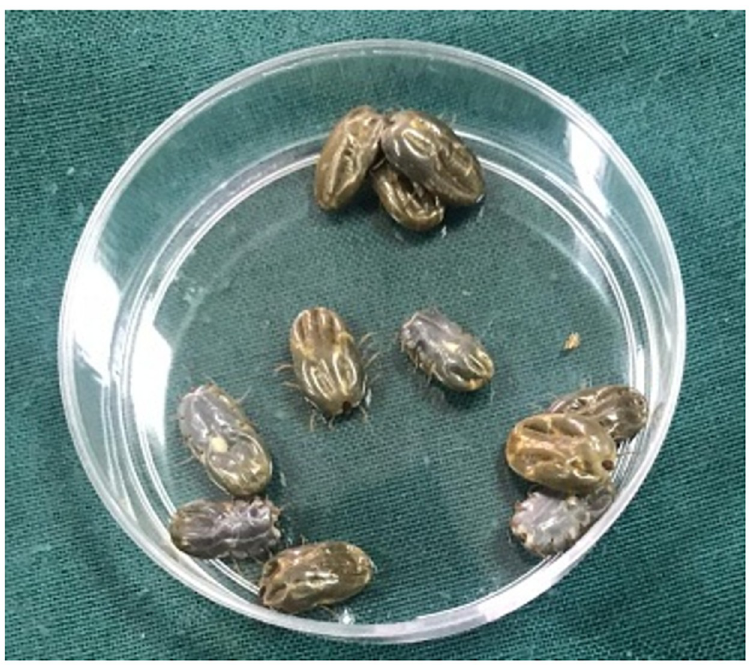
Fig 2. Adult engorged female Rhipicephalus annulatus (before application of any